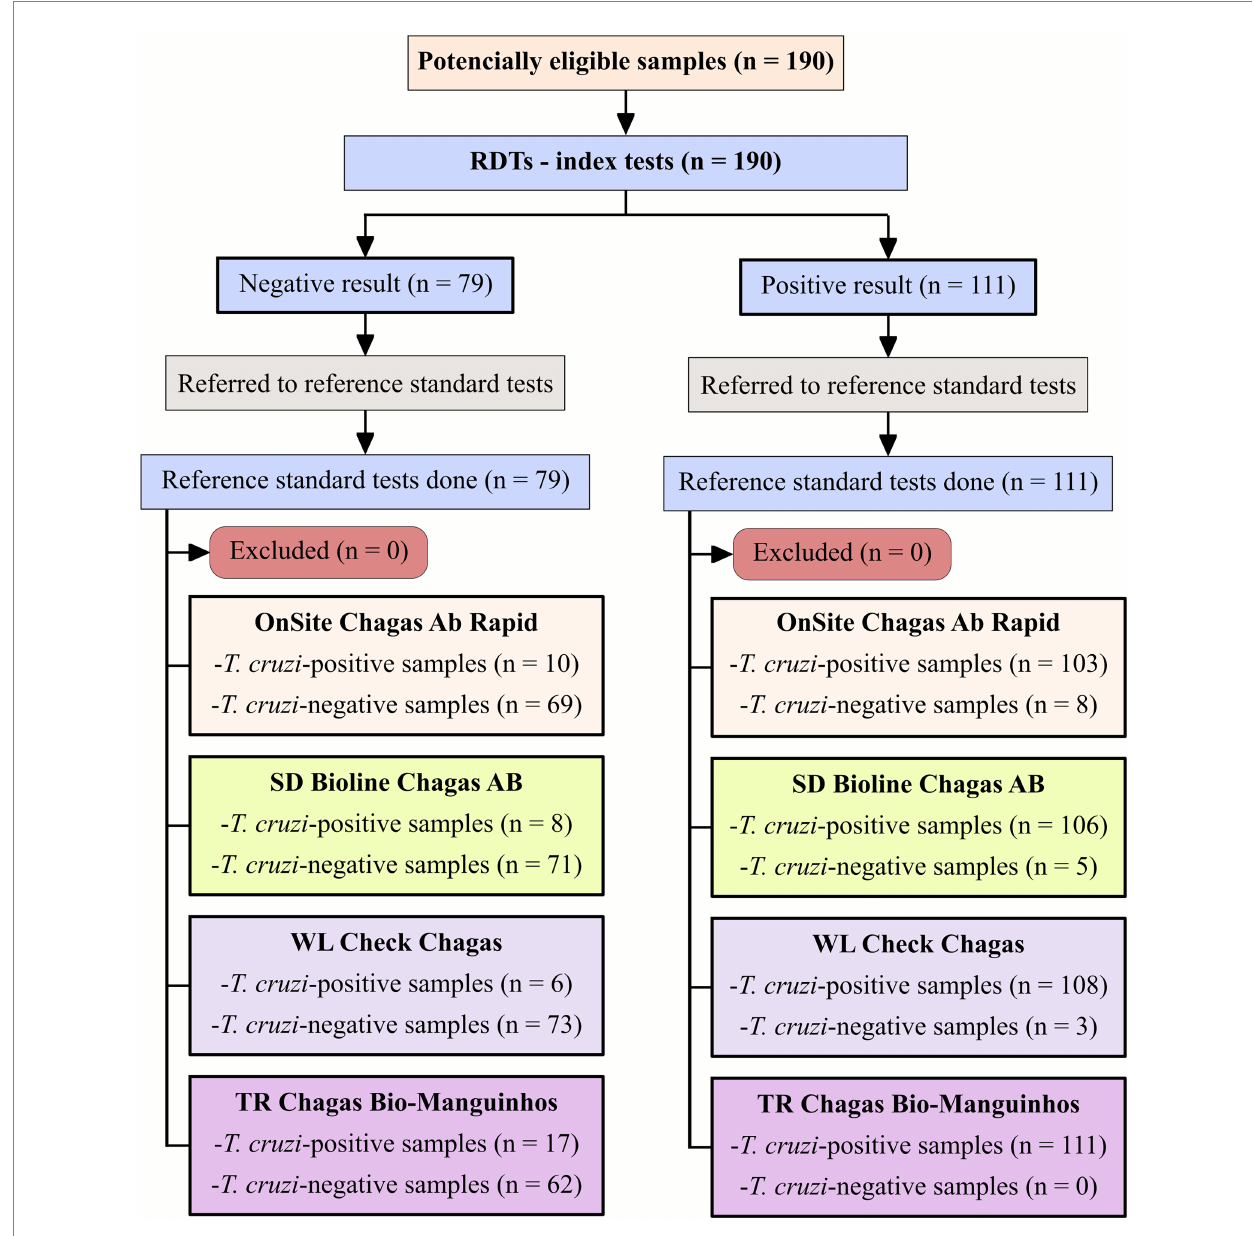
FIGURE 1 Flowchart depicting study design in accordance with the Standards for Reporting of Diagnostic Accuracy Studies (STARD) guidelines.